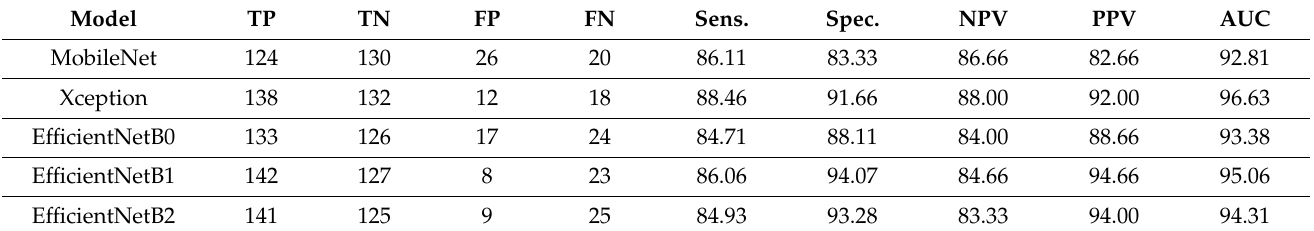
Table 2. Test scores of the five models.